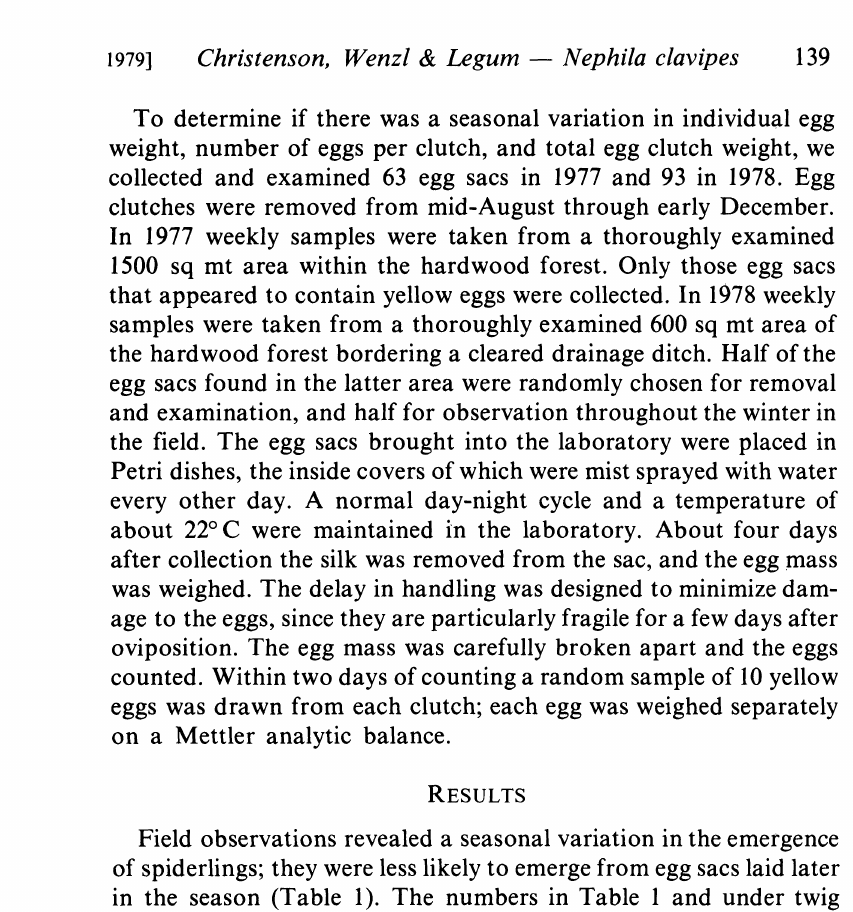
Table 1. Percentage of egg sacs from which no spiderlings emerged in the spring according to the trimester of the season in which the egg sac was formed. Each trimester represents about six weeks. Estimated numbers of failures are in paren- theses; see text for explanation of estimate. Trimester effect analyzed by Chi square test; data were collapsed across